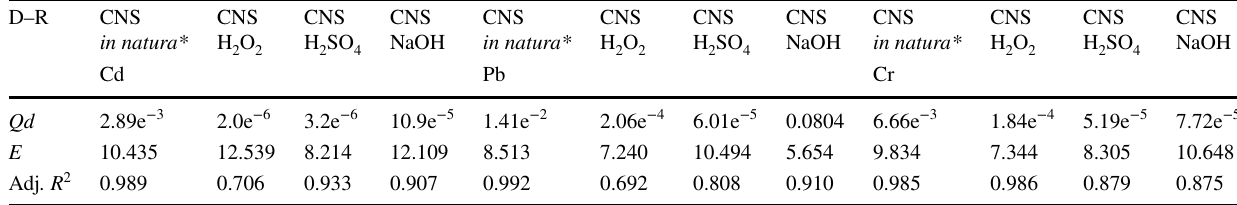
Table 9 Parameters of Dubinin–Radushkevich (D–R) related to adsorption of Cd 2+ , Pb 2+ and Cr 3+ on the shell of the cashew nut (CNS) in natura and modified with H 2 O 2 , H 2 SO 4 and